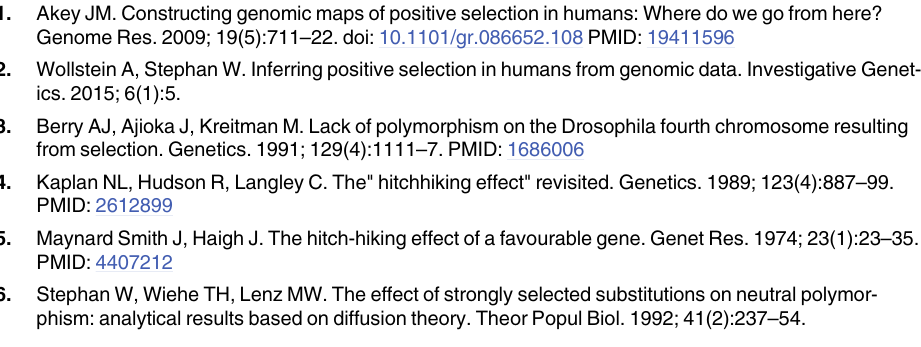
S1 Table. Parameters used for simulating training and test datasets of large chromosomal regions. S2 Table. Feature importance rankings for S/HIC classifiers trained on three different demographic histories. S3 Table. Extra-Trees classifier parameter grid search results for S/HIC classifiers trained on three different demographic histories. S4 Table. Predicted sweeps on chromosome 18 from the CEU sample from Phase I of the 1000 Genomes